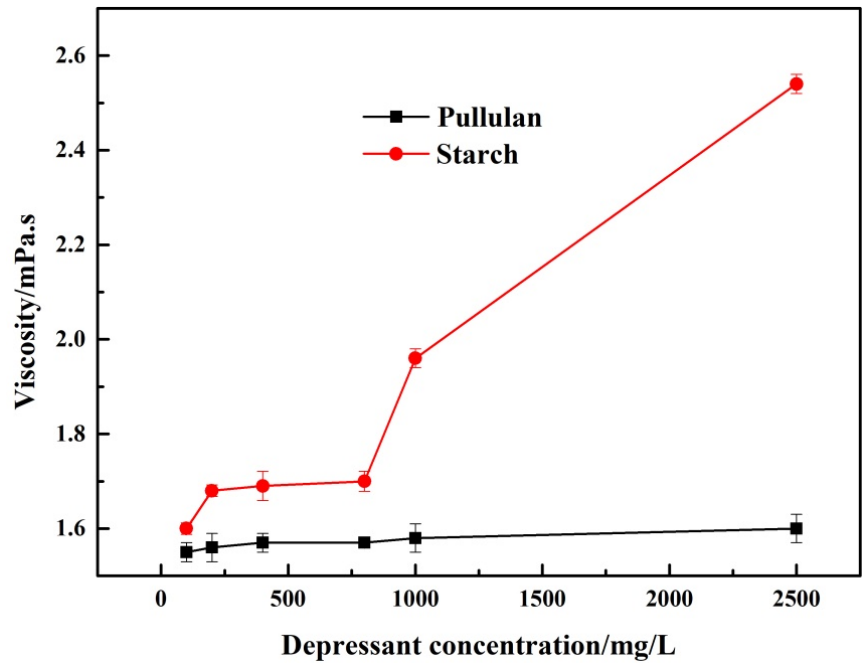
Figure 4. The viscosity of pullulan and starch.